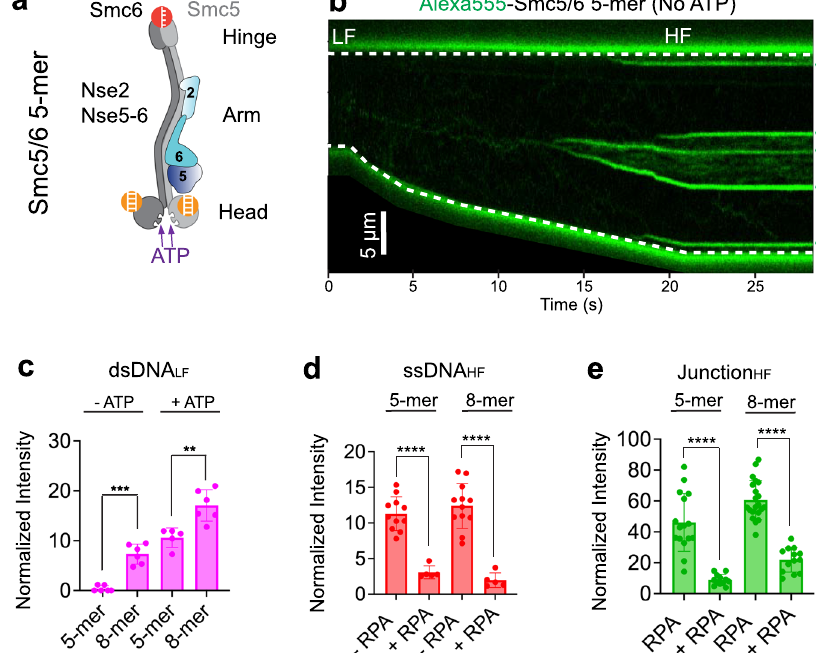
Fig. 3 | Nse1-3-4 subcomplex contributes to Smc5/6 ’ s association with DNA. a Schematic of the Smc5/6 5-mer complex, which lacks the Nse1-3-4 subcomplex. b Representativekymographofa λ DNAtetherbeingstretchedfromLFtoHFinthe presence of 20nM Alexa555-Smc5/6 5-mer (green) without ATP. dsDNA (blue), ssDNA (red), and junction DNA (green) regions of the tether are indicated to the right of the kymograph. c Fluorescence signals of Smc5/6 5-mer and 8-mer com- plexes on dsDNA under LF without or with ATP (no RPA). Bar heights indicate the groupmeananderrorbarsrepresentstandarddeviation. P valuesweredetermined from two-tailed unpaired t -tests with Welch ’ s correction (** P <0.01; *** P <0.001). P =0.0002 for − ATP condition, and P =0.0028 for +ATP condition. Sample sizes are:5-merdsDNA LF − ATP( n =6);8-merdsDNA LF − ATP( n =6);5-merdsDNA LF +ATP ( n =5); and 8-mer dsDNA LF +ATP ( n =6), where n indicates the number of regions analyzed. d Fluorescence signals of Smc5/6 5-mer and 8-mer complexes on ssDNA